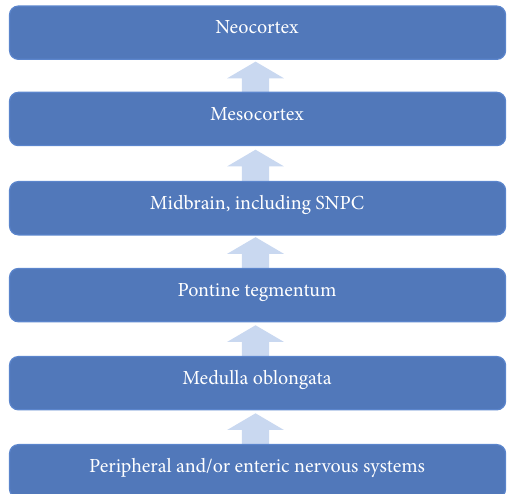
Figure 3: The 6 stages of PD according to the Braak hypothesis. Pathology begins in the enteric nervous system and progresses to the